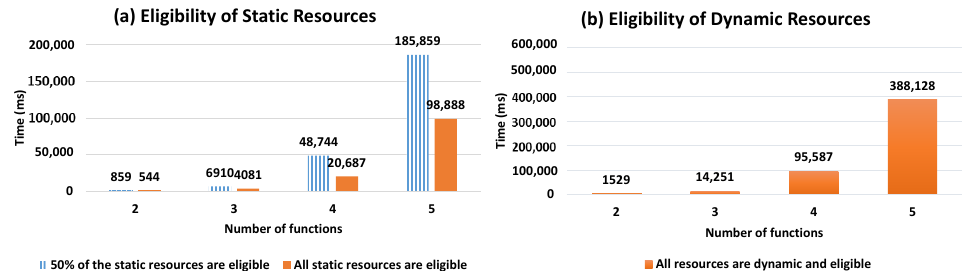
Figure 12. Response time while the varying number of